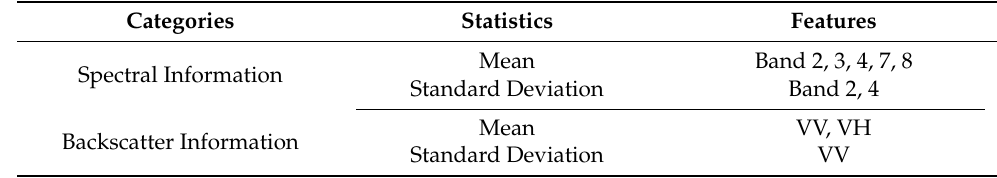
Table 6. Feature subset of multispectral and SAR bands screened by